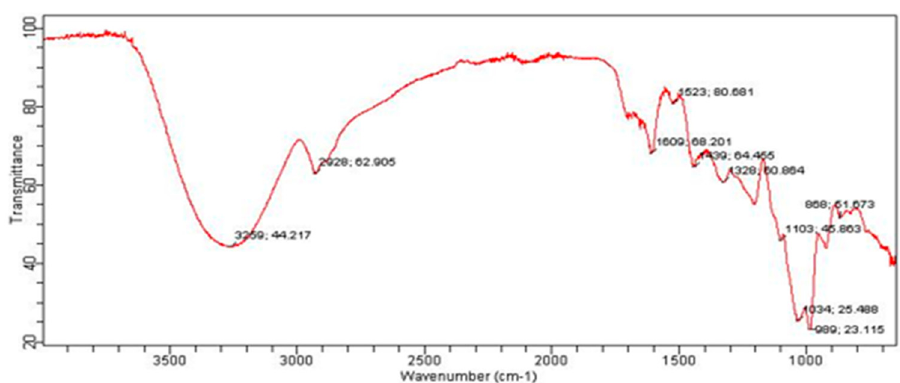
Figure 5. FTIR spectrum of EBC.